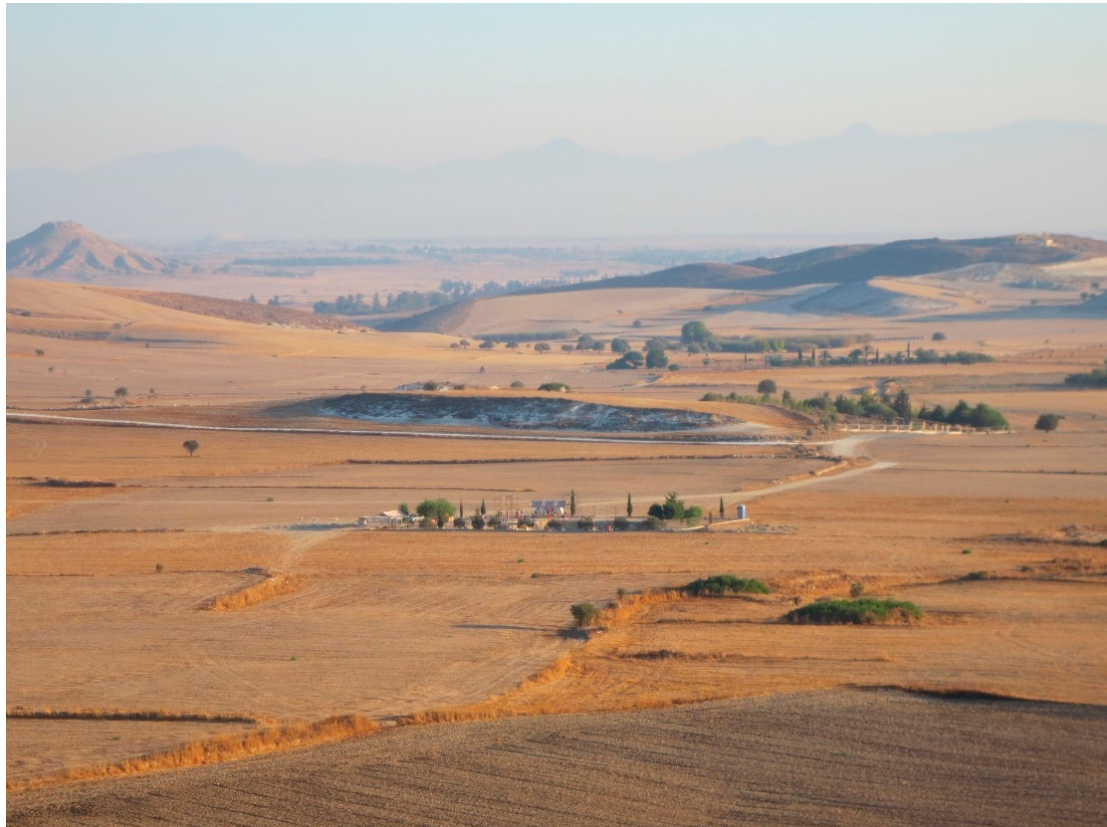
Figure 3. View of the Cypriot hinterland. The valley of Malloura and its ancient sanctuary (center) in the Mesaoria region of Cyprus looking north to the Kyrenia mountain range. Photo by J.M. Gordon.